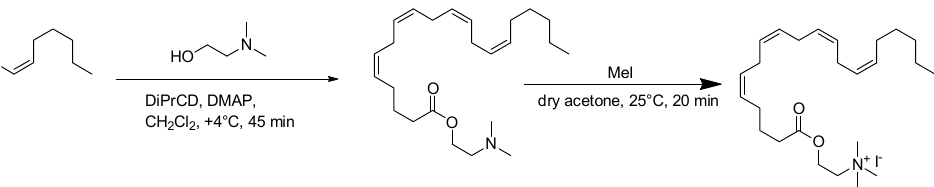
Figure 1. The structures of the synthesized acylcholines.